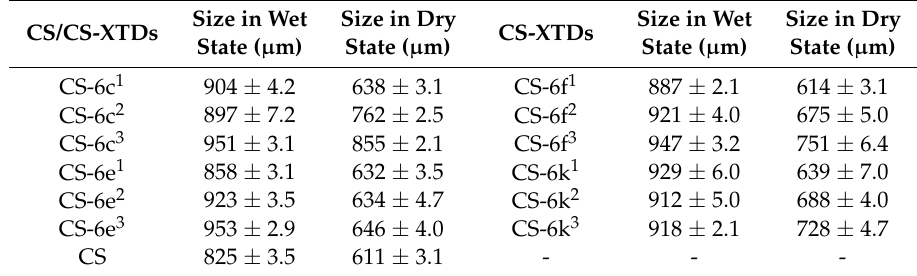
Table 1. Microparticles size of CS and CS-XTDs (CS-6c, CS-6e, CS-6f, CS-6k) at different